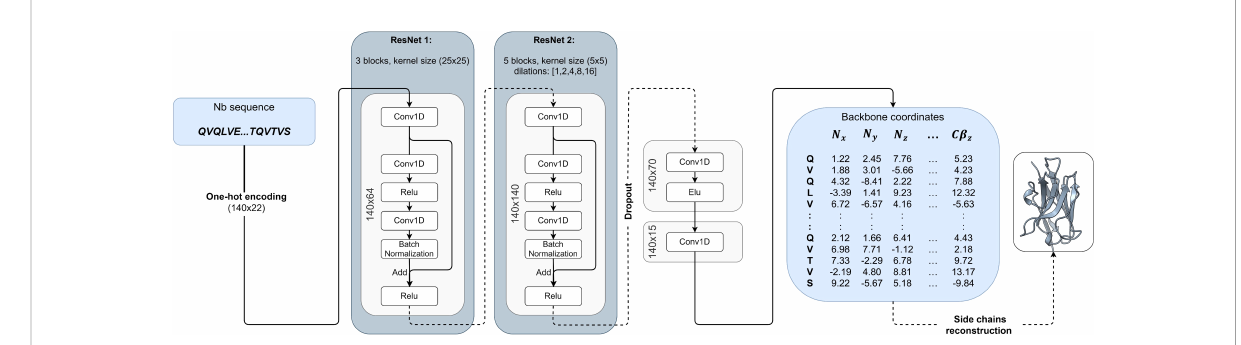
FIGURE 1 NanoNet architecture: The input of the network is the one-hot encoding of the sequence that goes into two 1D ResNets. The output is the 3D